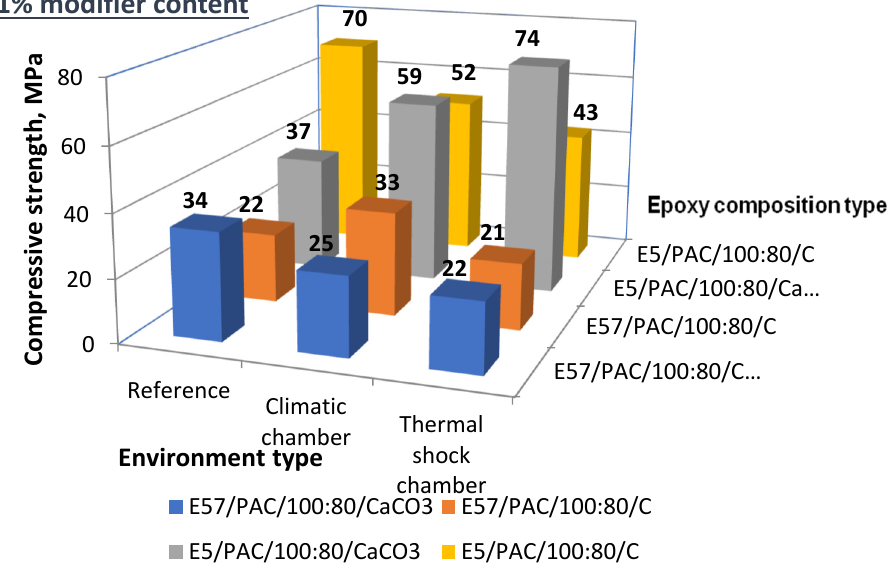
Figure 27. Compressive strength of the 1% filler epoxy compounds post-aging under different conditions.